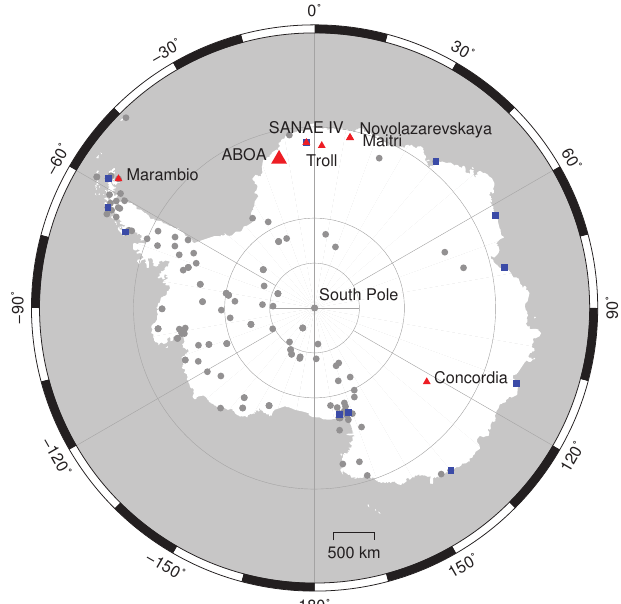
Figure 1. Location of the Finnish research station Aboa within the Antarctic continent. The red triangles show the location of the research stations visited by the Finnish researchers during the Antarctic summers. The blue squares denote the IGS GPS stations for which the time series are longer than 15 years [40]. The grey dots show the location of other episodic and/or continuous GPS stations established in Antarctica and reported by the Nevada State Laboratory